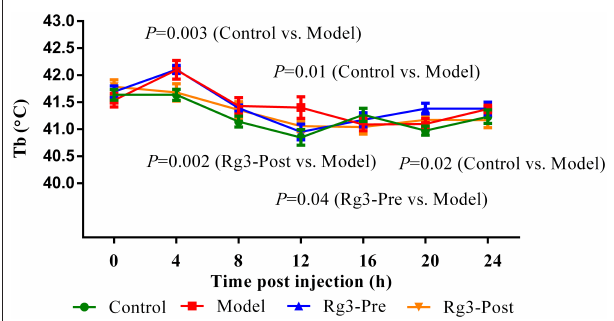
FIGURE 2 | Continuous body temperature (Tb) record in broilers. Continuous monitoring of body temperature post-lipopolysaccharide injection. Values are represented as means ± SE ( n =